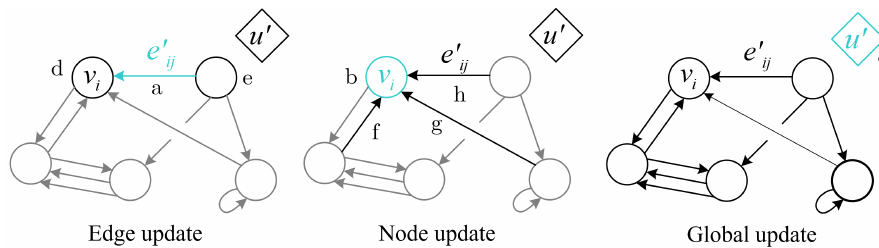
Figure 1. Update process of